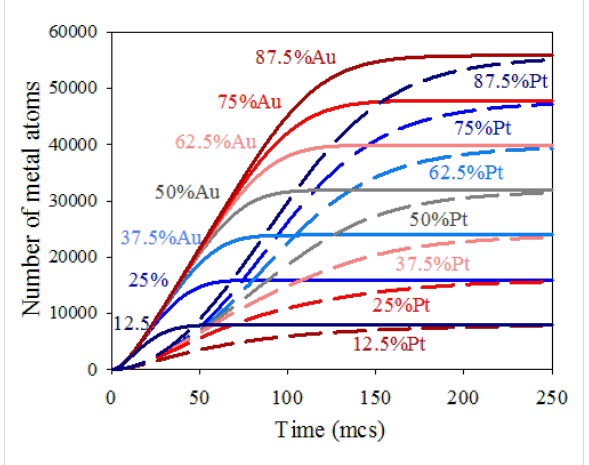
Figure 2: Time evolution of the number of metal atoms obtained in micelles. Continuous and discontinuous lines show the resulting Au and Pt, respectively. Synthesis conditions: flexible film ( k ex = 5, f = 30), reduction rate ratio v Au /v Pt = 10; average concentration = 64. Scheme color: dark blue lines: 12.5% Au, = 16, = 112; middle blue lines: 25% Au, = 32, = 96; light blue lines: 37.5% Au, = 48, = 80; grey lines: 50% Au, = 64, = 64; light red lines: 62.5% Au, = 80, = 48; middle red lines: 75% Au, = 96, = 32; dark red lines: 87.5% Au, = 112, =